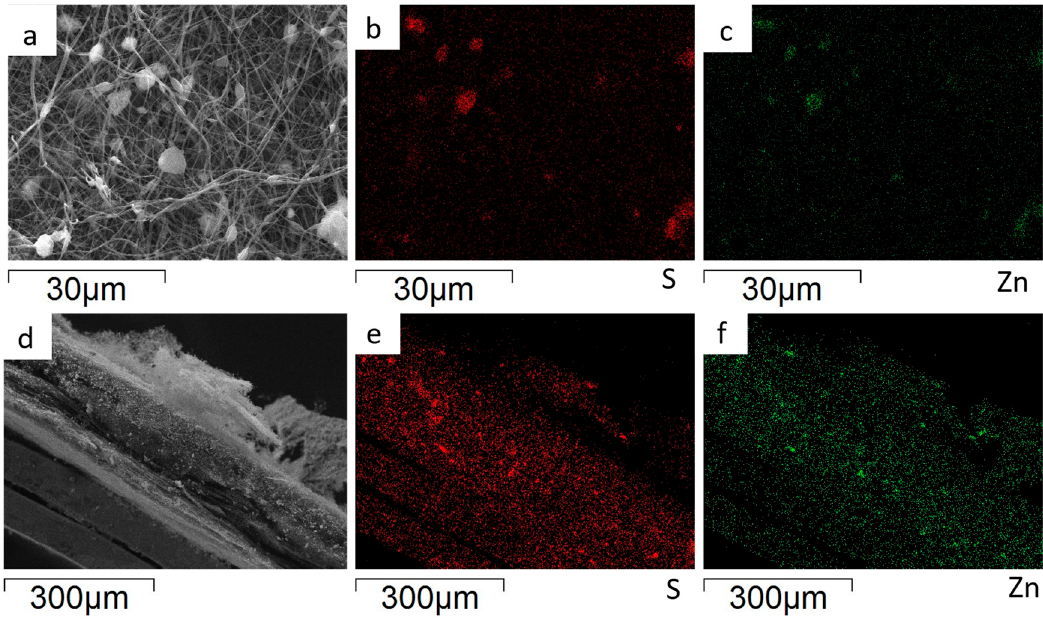
Figure 6. 10%ZnS–GO/CNF anode: sample surface portion ( a ) and distribution maps of S ( b ) and Zn ( c ); cross-section portion ( d ) and distribution maps of S ( e ) and Zn ( f ).